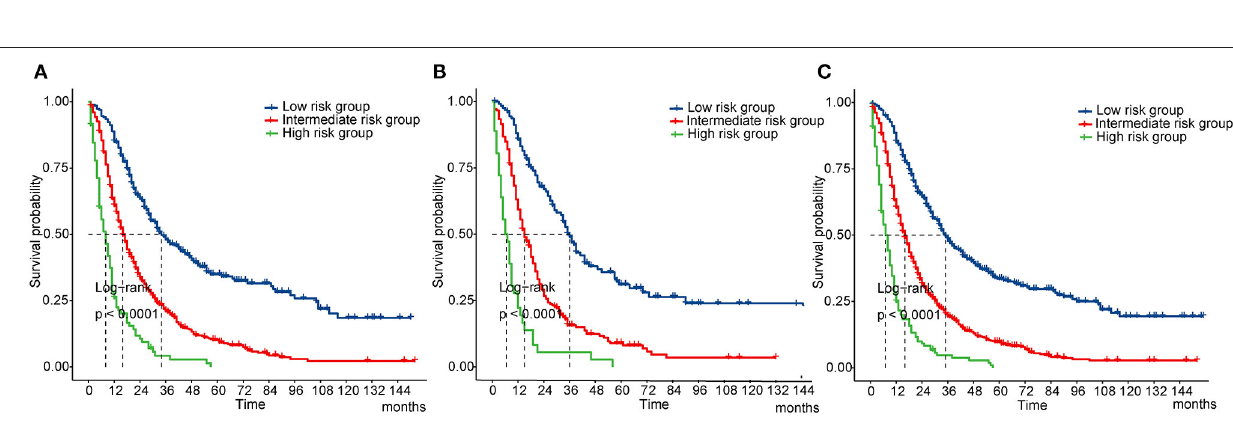
Frontiers in Surgery |